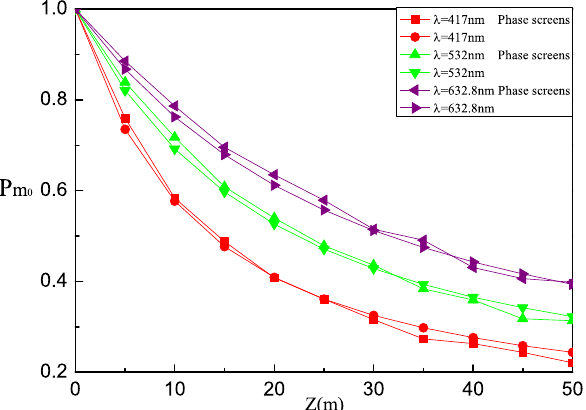
Figure 5. Detection probability P m parameter of wavelength λ